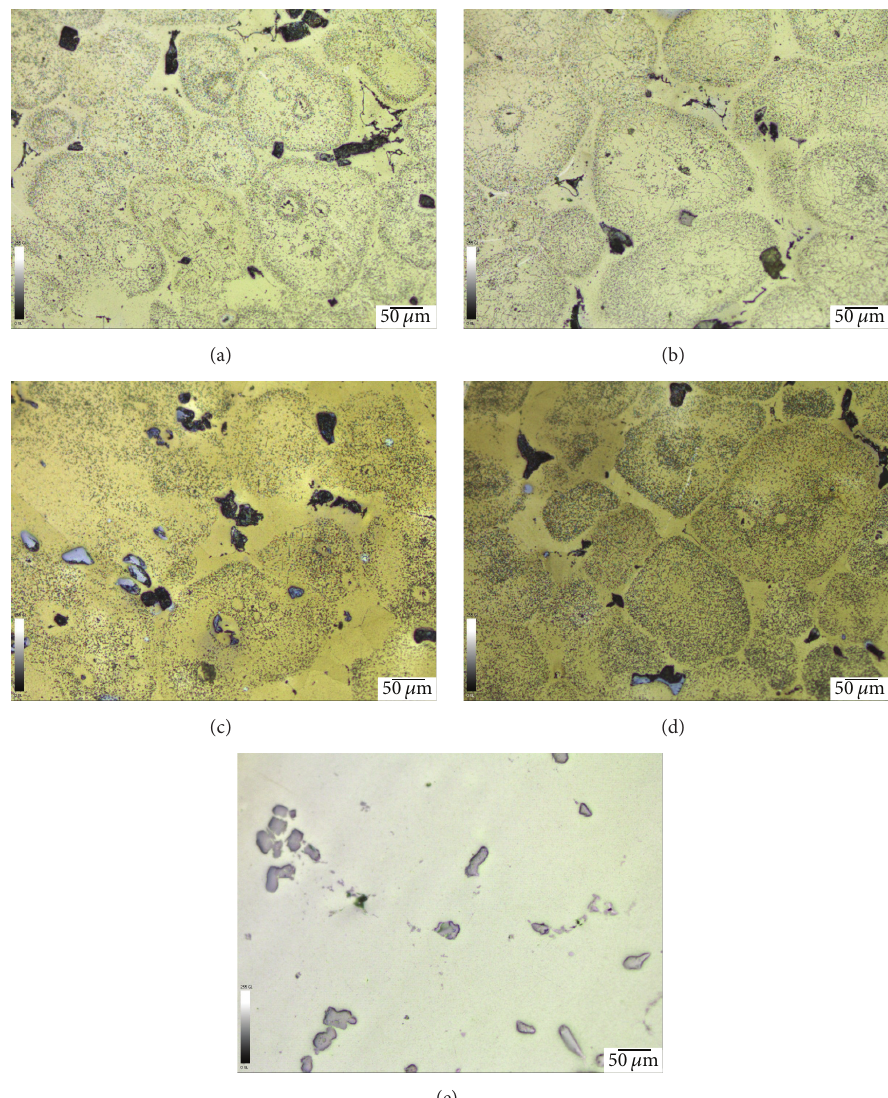
Figure 9: Microstructure of samples thixoforged of the Al4.8 wt% Cu alloy (a) 𝑓 𝑠 = 0.6 and resting time 20 min, (b) 𝑓 𝑠 = 0.6 and resting time 30 min, (c) 𝑓 𝑠 = 0.8 and resting time 20 min, (d) 𝑓 𝑠 = 0.8 and resting time 30 min, and (e) 𝑓 𝑠 = 0.6 and resting time 20 min without